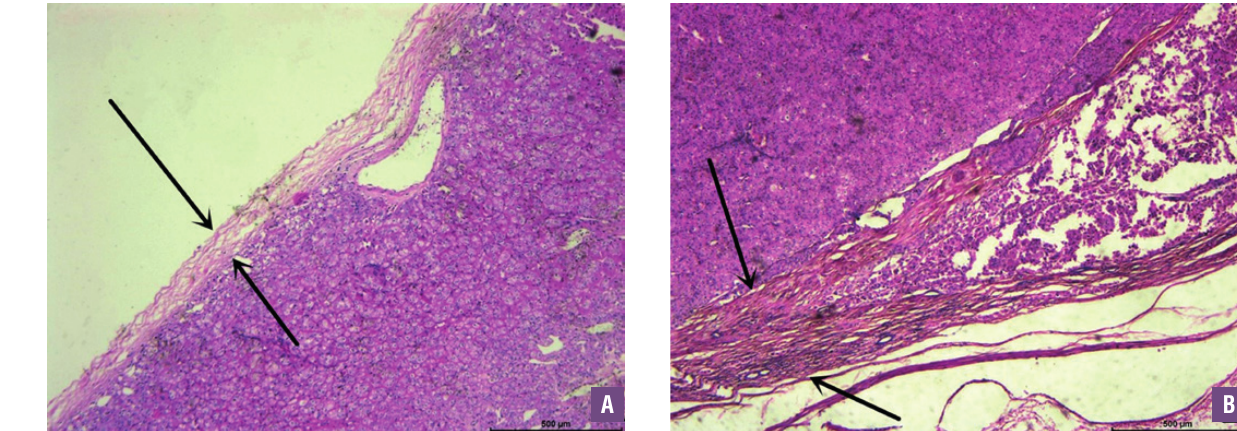
intact pseudocapsule (HE*40).